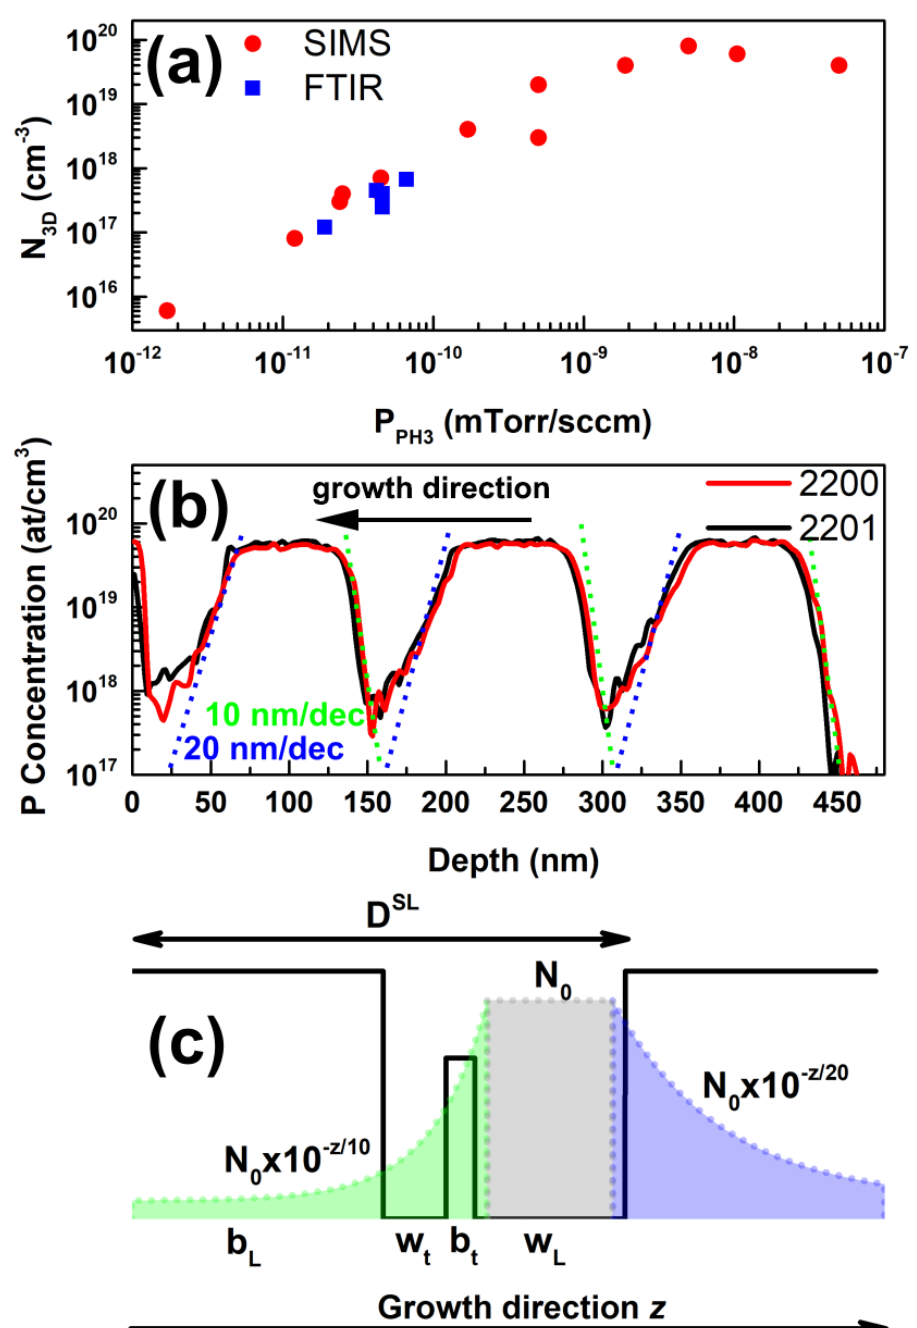
Figure 3. ( a ) Correlation (red dots) between the N 3 D concentration of P dopants obtained by secondary ion mass spectrometry (SIMS) and the growth parameter P PH 3 , i.e., the phosphine partial pressure normalized to the flux of the co-deposited germane gas. The same correlation plot (blue squares) but with the N 3 D = n 2 D / t values obtained from the sheet carrier density n 2 D measured by FTIR and the thickness t of the doped layer. ( b ) Spatial profile of P dopants along the growth direction z obtained by SIMS on two calibration samples featuring alternating doped and intrinsic layers. The di ff usion tail of P atoms for the doped / undoped (undoped / doped) interfaces have been fitted to a mono-exponential decay function N 0 × 10 − z / d displayed as green (blue) dots, where d is the characteristic decay length and N 0 the N 3 D density inside the doped layer. ( c ) Schematics of the ACQW module. The geometric parameters mentioned in the text are indicated. In the exponent of the decay function, z is in nanometer. The donor di ff usion in the leading and trailing directions is pictured.